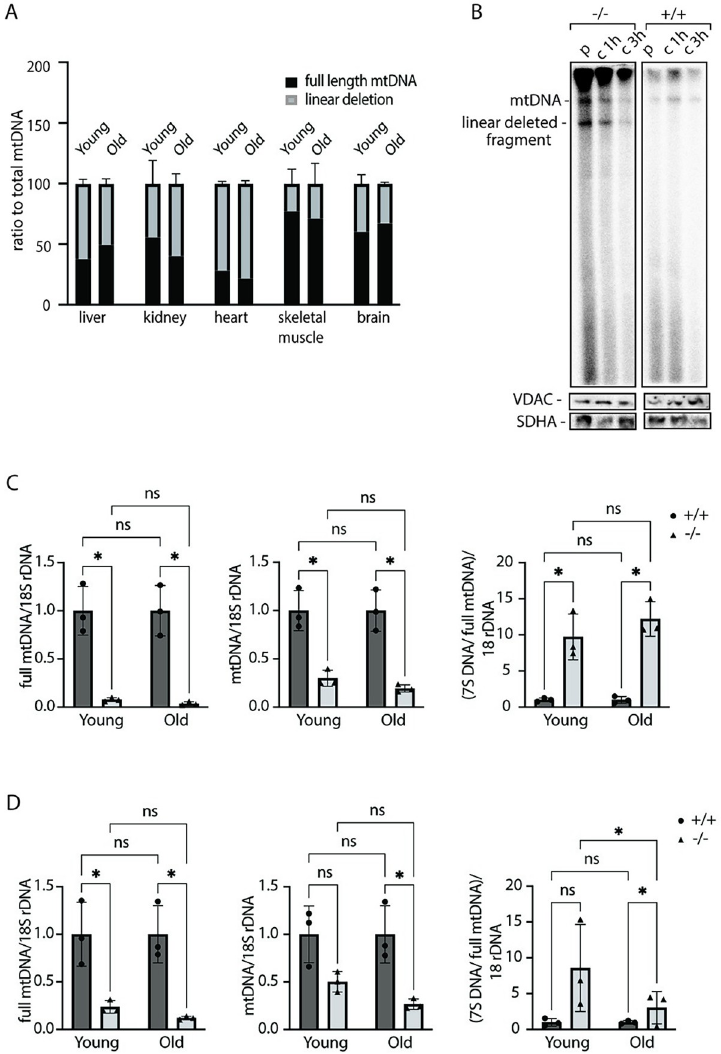
Fig 2. Linear deleted subgenomic fragments do not accumulate with age in Mgme1 -/- mice. (A) Southern blot quantification of linear deletion fragment signal in ratio to total mtDNA signal in liver, kidney,heart, skeletal muscle and brain of Mgme1 -/- mice at 10 and 50 weeks of age. Error bars represent SD. (B) De novo DNA synthesis in heart mitochondria isolated from control (+/+) and Mgme1 knockout (-/-) mice. Mitochondria were pulse labeled (p) for 2 h and the chase was performed for 1 and 3 h. SDHA and VDAC levels on western blot represent loading control for the input mitochondria. (C) Quantification of full length mtDNA (left panel), total mtDNA (middle panel) and 7S DNA (right panel) in wild-type and MGME1 knock-out heart tissue of young (10 weeks) and old (55 weeks) animals. Values are given as mean ± SD. � P � 0.05, T-test. (D) As (C) but in kidney tissue. monolayer under the lens capsule without gaps or derangement of adjacent fiber cells. The lens matrix of the Mgme1 -/- mice contained migrated epithelial cells and the normally densely packed and regularly arranged fiber cells in the lens matrix were swollen and abnormally arranged (Fig 3C). All retinal layers were present in Mgme1 knockout mice, but the total reti- nal thickness as well as the thickness of each of the three retinal layers, i.e., outer plexiform layer (OPL), inner nuclear layer (INL) and outer nuclear layer (ONL) near the optic nerve was reduced in the Mgme1 -/- mice (Fig 3D and 3E).